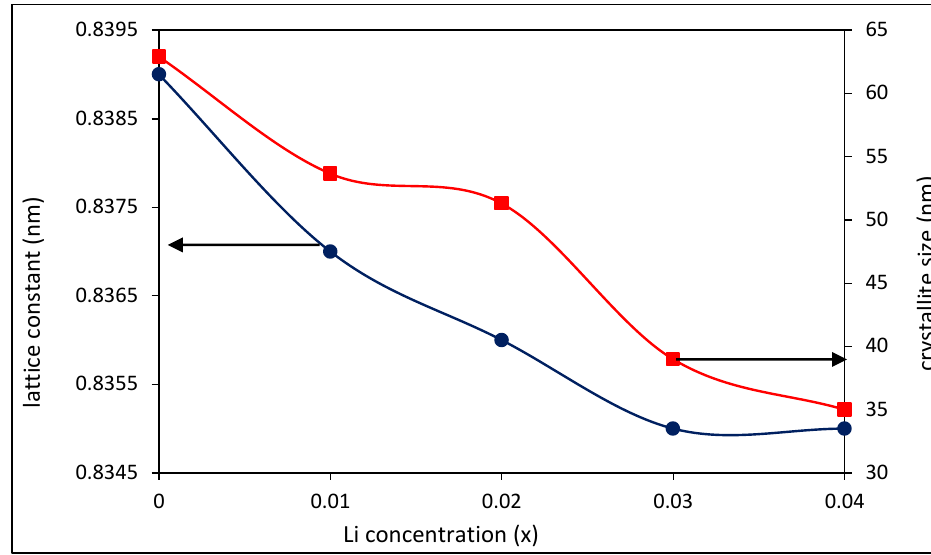
Fig. 3: Variation of lattice constants and crystallite size with Li + ions concentration.